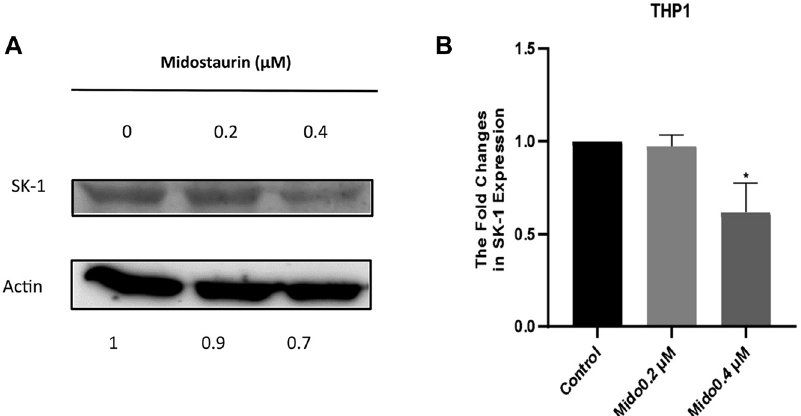
Figure 1: SK-1 expression in midostaurin- treated THP1 (A) and (B) cells for 48 h.